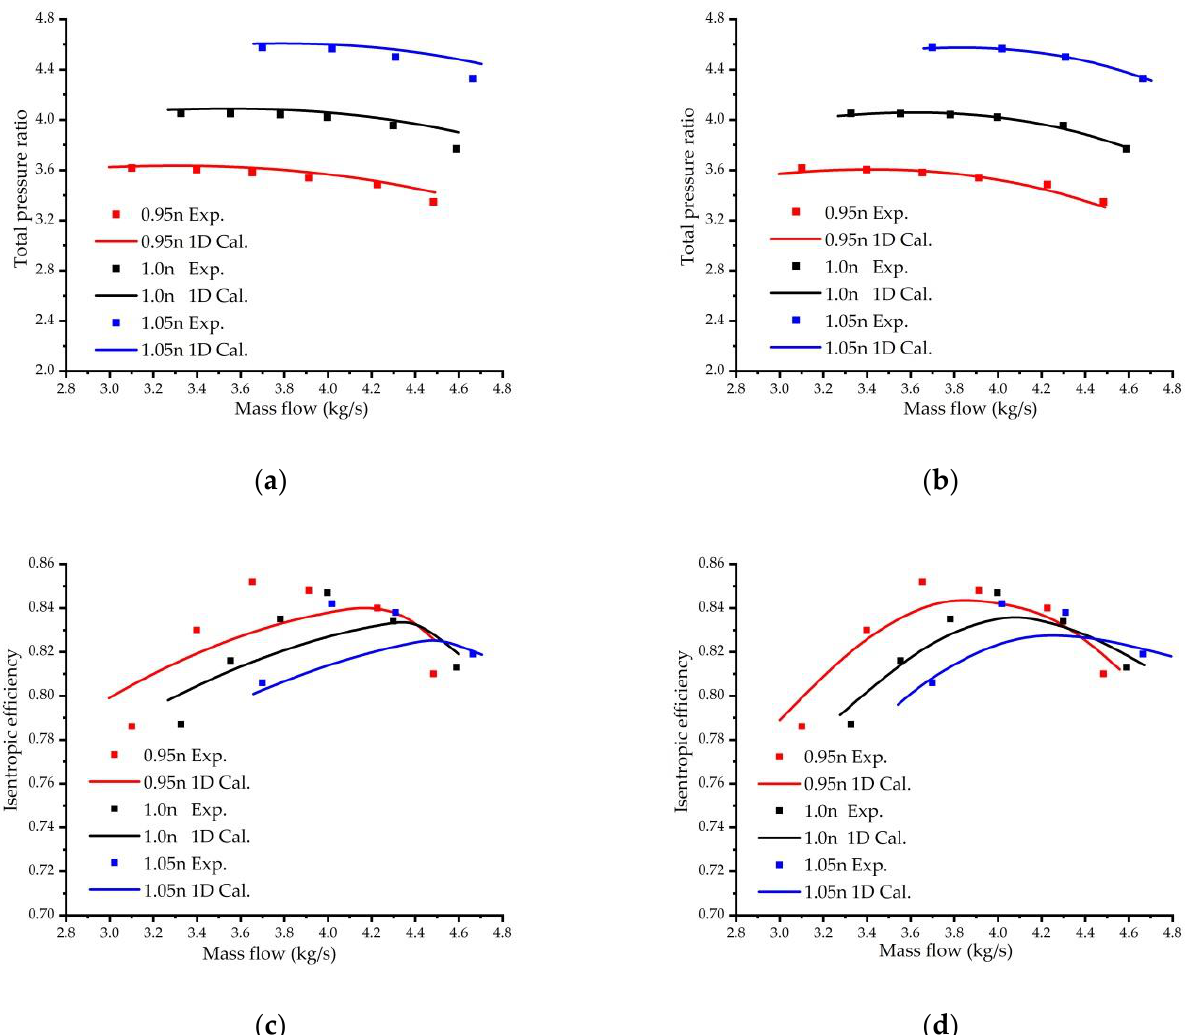
Figure 11. Comparisons of 1D predicted performance before and after optimization for the Krain impeller: ( a ) Total pressure ratio before optimization; ( b ) Total pressure ratio after optimization; ( c ) Efficiency before optimization; ( d ) Efficiency after optimization.